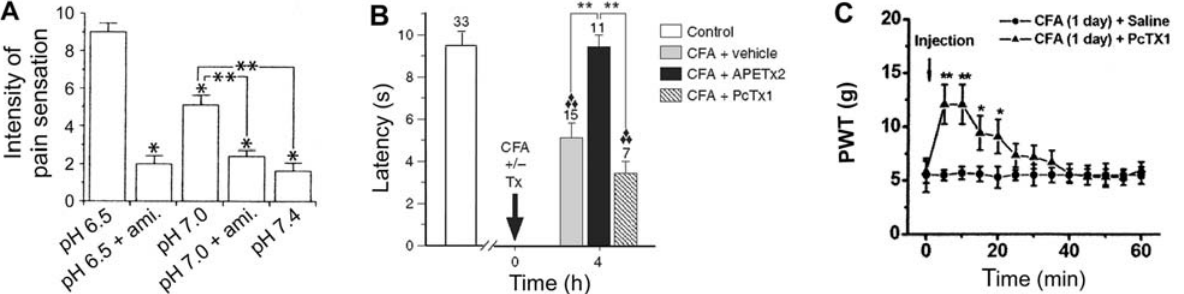
Figure 1. ASICs are essential detectors of acid- and inflammation-induced pain. ( A ): analgesic effect of amiloride (ami.; 200  M), a general inhibitor of ASICs, on intradermal acid (pH 6.5 and 7.0) infusion-evoked pain in human subjects. Amiloride treatment potently suppressed the acid-evoked pain down to the pH 7.4 control level. * P < 0.01 vs. pH 6.5 treatment; ** P < 0.01 vs. pH 7.0 treatment ( n = 10). Adapted with permission from ref. [47]. ( B ): intraplantar injection with complete Freund’s adjuvant (CFA) -induced thermal hyperalgesia in rats was prevented by APETx2 (20  M), a specific inhibitor of ASIC3; whereas PcTx1 (120 nM), a specific inhibitor of homomeric ASIC1a, had no significant effect. Hind paw withdrawal latencies were measured at 50 °C, and the time at which inflammation was induced is indicated by the arrow. ** P < 0.01; ♦♦♦ P < 0.001, significantly different from control. Adapted with permission from ref. [50]. ( C ): CFA- induced mechanical hypersensitivity in rats, as determined by the paw withdrawal threshold (PWT) test using von Frey stimulation, is attenuated by intrathecal injection of PcTx1. * P < 0.05; ** P < 0.01 compared with intrathecal saline injection ( n = 6). Adapted with permission from ref.